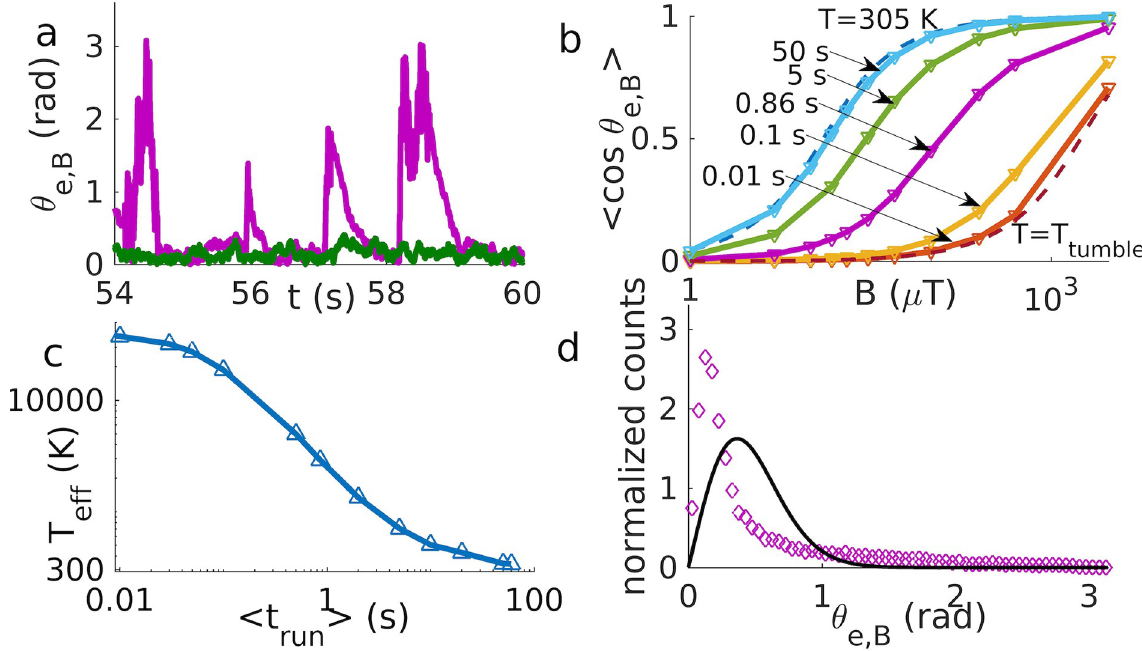
Fig 3. Motion with magnetic torque. a) Alignment angle vs. time for run and tumble (in purple) and run and reverse (in green) for a mean run time of 0.86 s at 500 μ T. b) Langevin plots for run and tumble compared to theoretical Langevin functions at T and T tumble (dashed lines). Each line corresponds to a different mean run time. c) The effective temperature obtained by the Langevin fit in b) is plotted against the mean run time. d) The distribution of the alignment angle for run and tumble with a mean run time of 0.86 s at 500 μ T (data points) deviates from the thermal distribution with the corresponding effective temperature, 2896K (solid